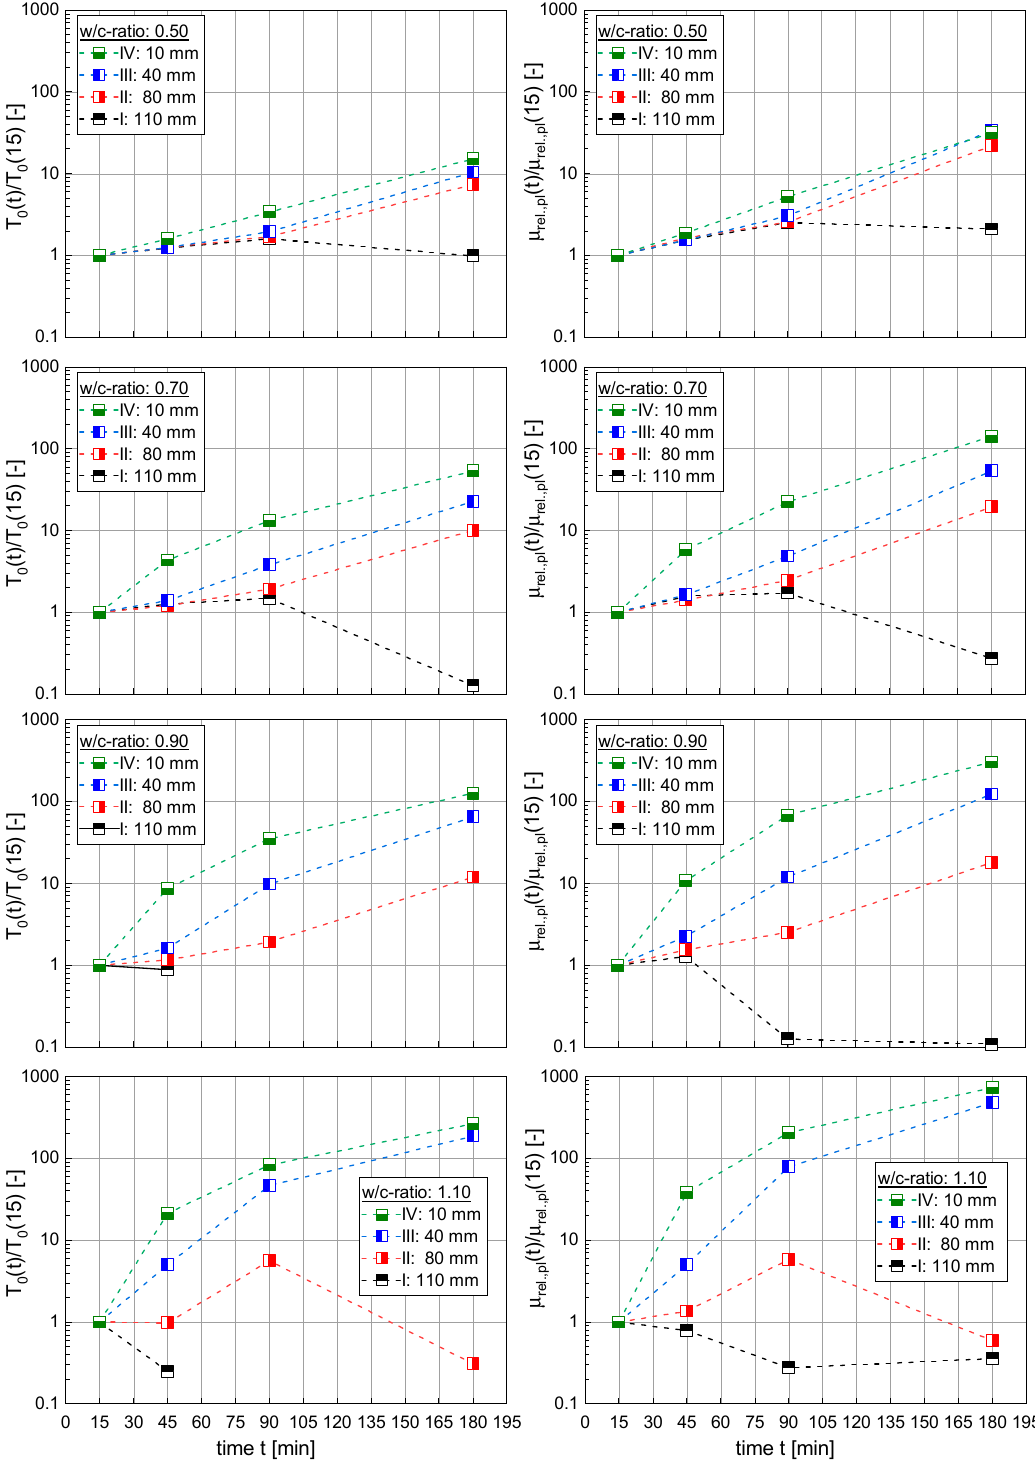
Figure 8. Temporal evolvement of the yield torque T 0 (left side) and the relative plastic viscosity µ rel.,pl (right side) of cement suspensions (w / c-ratios: 0.5, 0.7, 0.9 and 1.1) at four measuring heights (I–IV) within the sample normalized by the initial values at a sample age of 15 min.